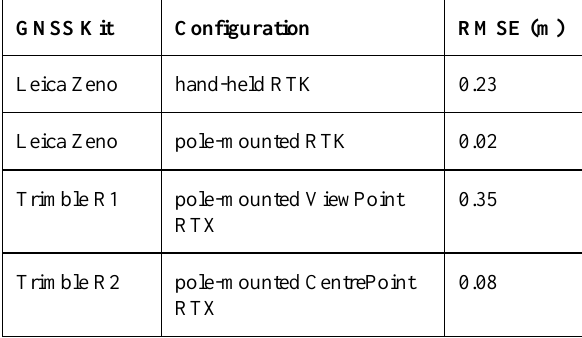
Table 1. GPS positional accuracy